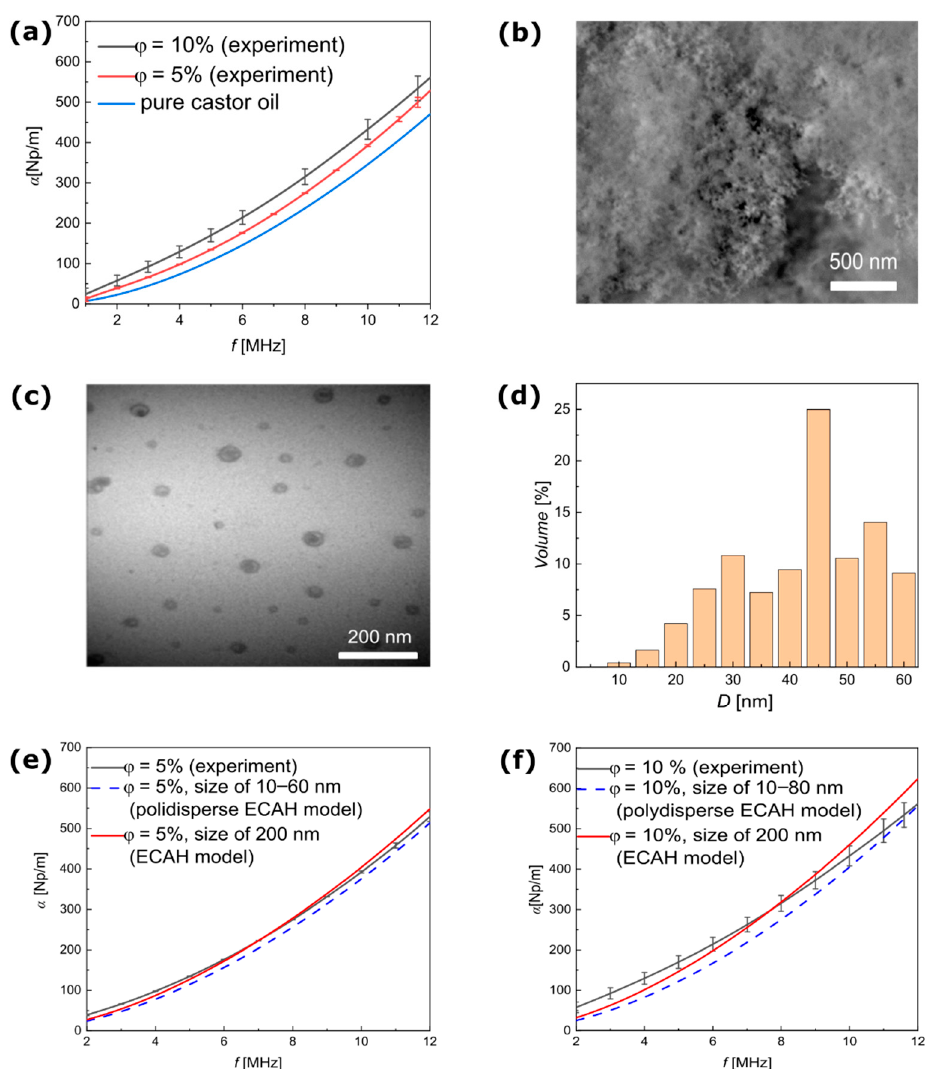
Figure 3. Experimental and theoretical results of ultrasound attenuation of silica NPs dispersed in castor oil. ( a ) Ultrasound attenuation coefficient versus the frequency measured for the mass concentrations of particles at 5% and 10%. ( b ) SEM image of the silica NPs. ( c ) TEM image of the silica NPs [27] . ( d ) PSD of the silica NPs calculated from the TEM image. ( e ) Comparison of the ultrasound attenuation coefficient versus frequency, measured and calculated based on the ECAH model for mass concentration of particles at 5% and ( f ) 10%.